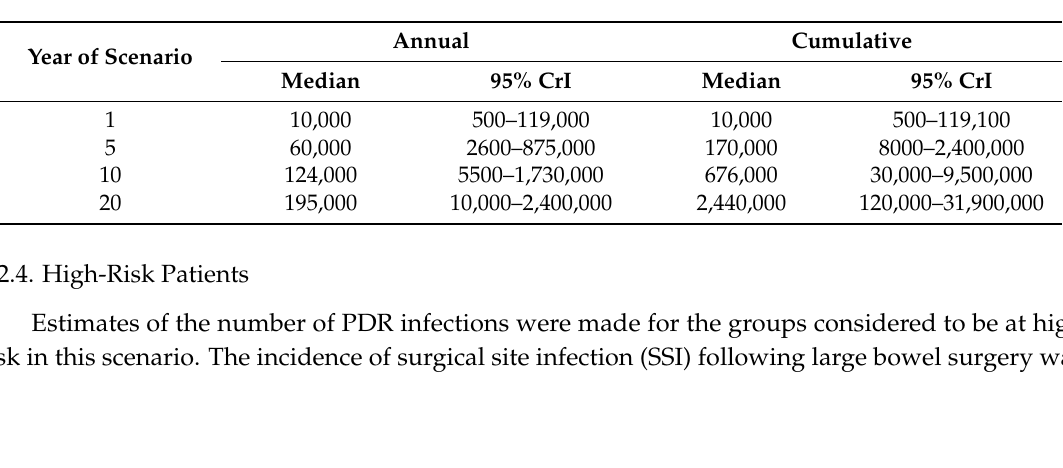
Table 4. Point and interval estimates for the annual and cumulative additional days length of stay (LoS) attributable to PDR Gram-negative bacteraemia in the UK for selected years of the